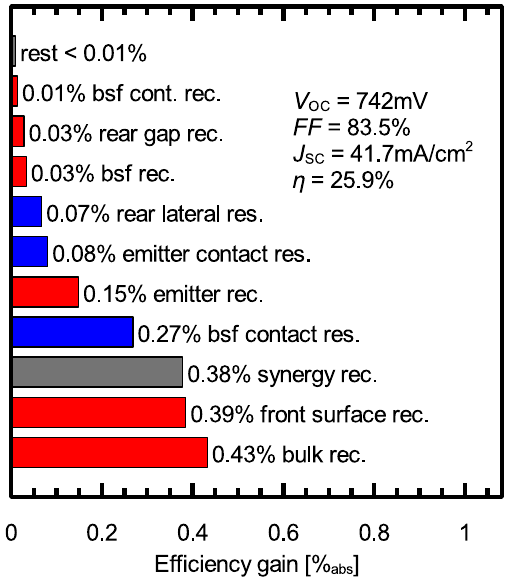
2 Figure 6. SEGA for the POLO IBC cell discussed in this study. Red bars show potential efficiency gains due to recombination, green bars gain due to optical losses and blue bars gain due to resistive losses. The gray bars show synergistic